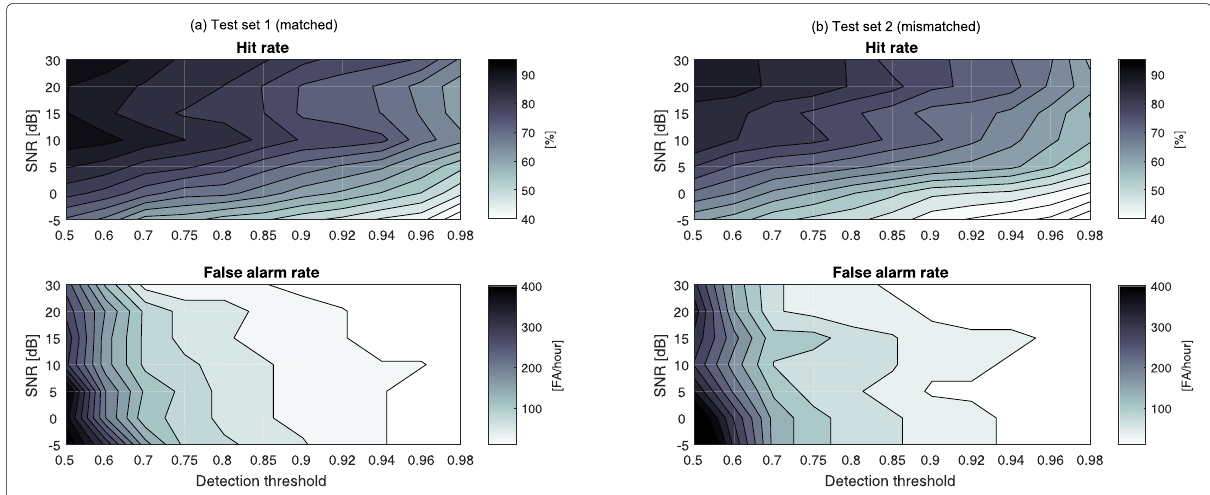
Fig. 9 Continuous audio stream test results. Hit rate and false alarm rates are shown as a function of SNR and detection threshold in a matched noise conditions (noise set 1) and b mismatched noise conditions (noise set 2). The trade-off between the hit rate and the false alarm rate can be controlled by selection of the detection threshold